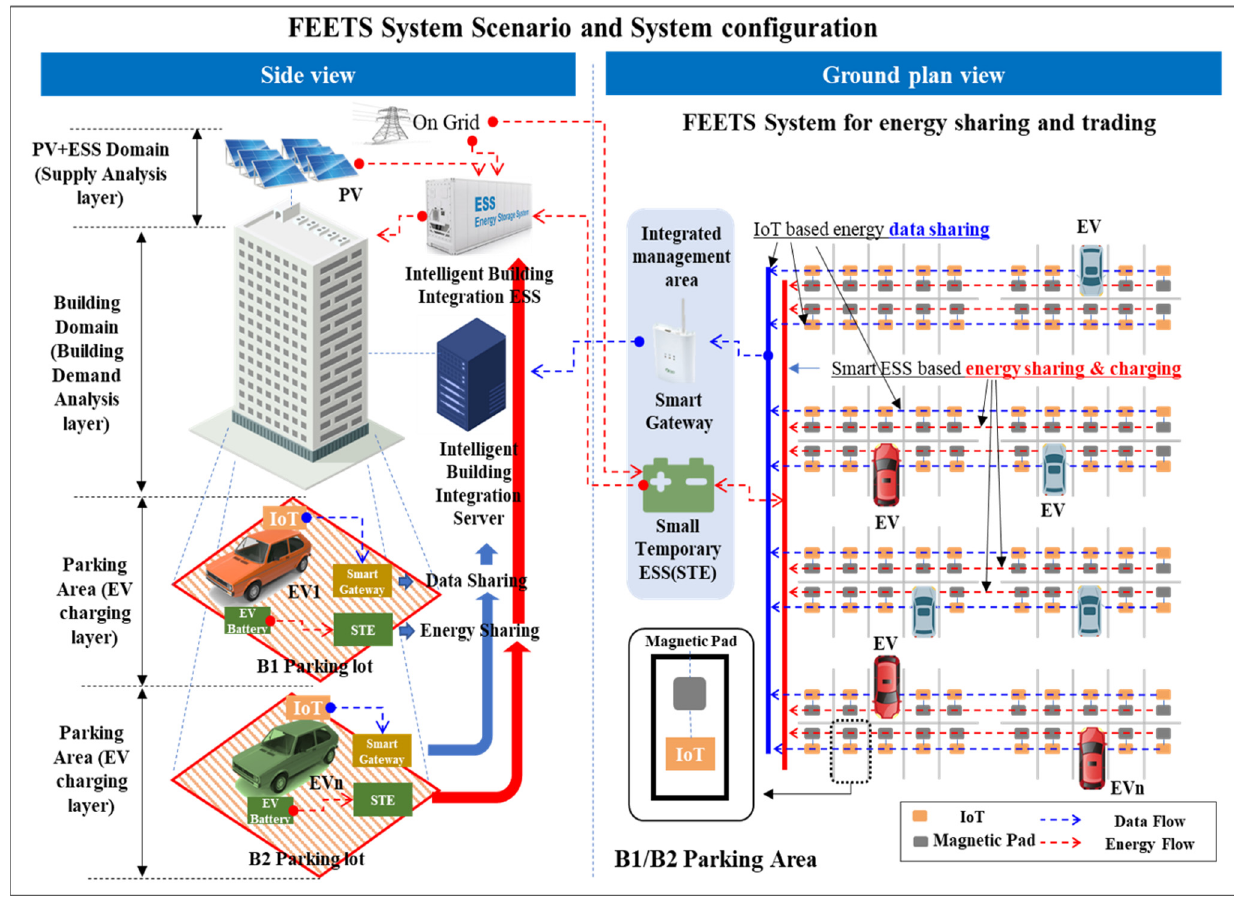
Figure 14. FEETS System configuration and energy, data flow scenario.